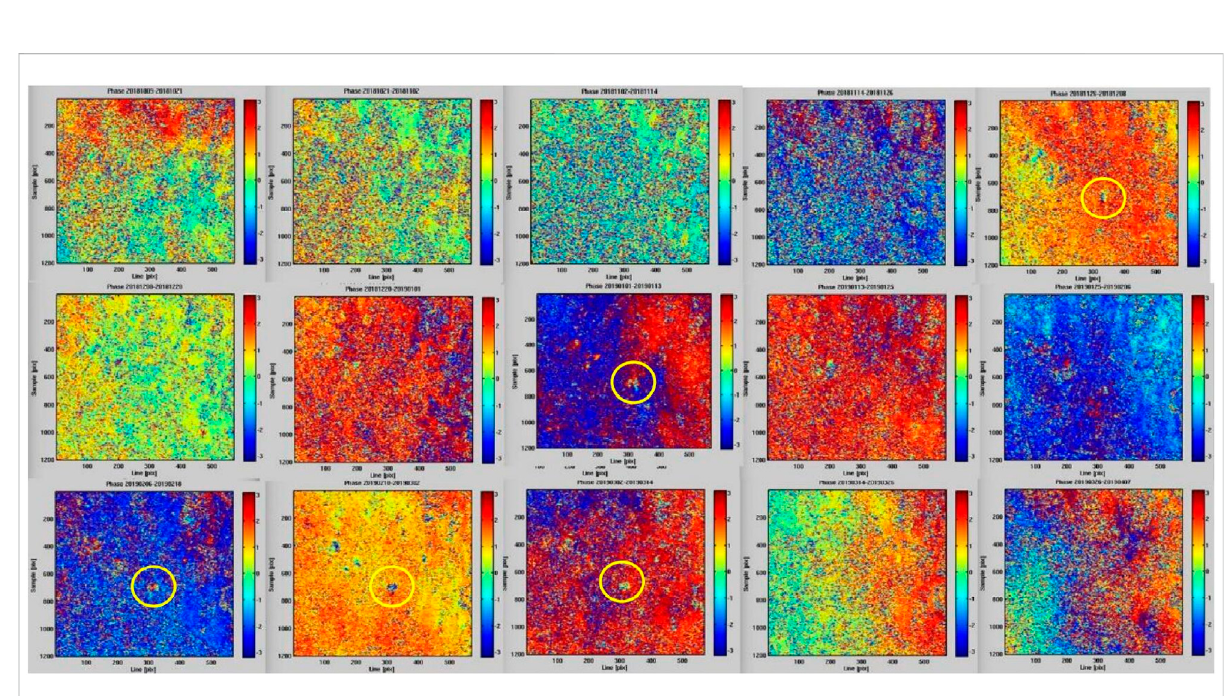
FIGURE 10 9 October 2018 to 7 April 2019 DInSAR decoding results